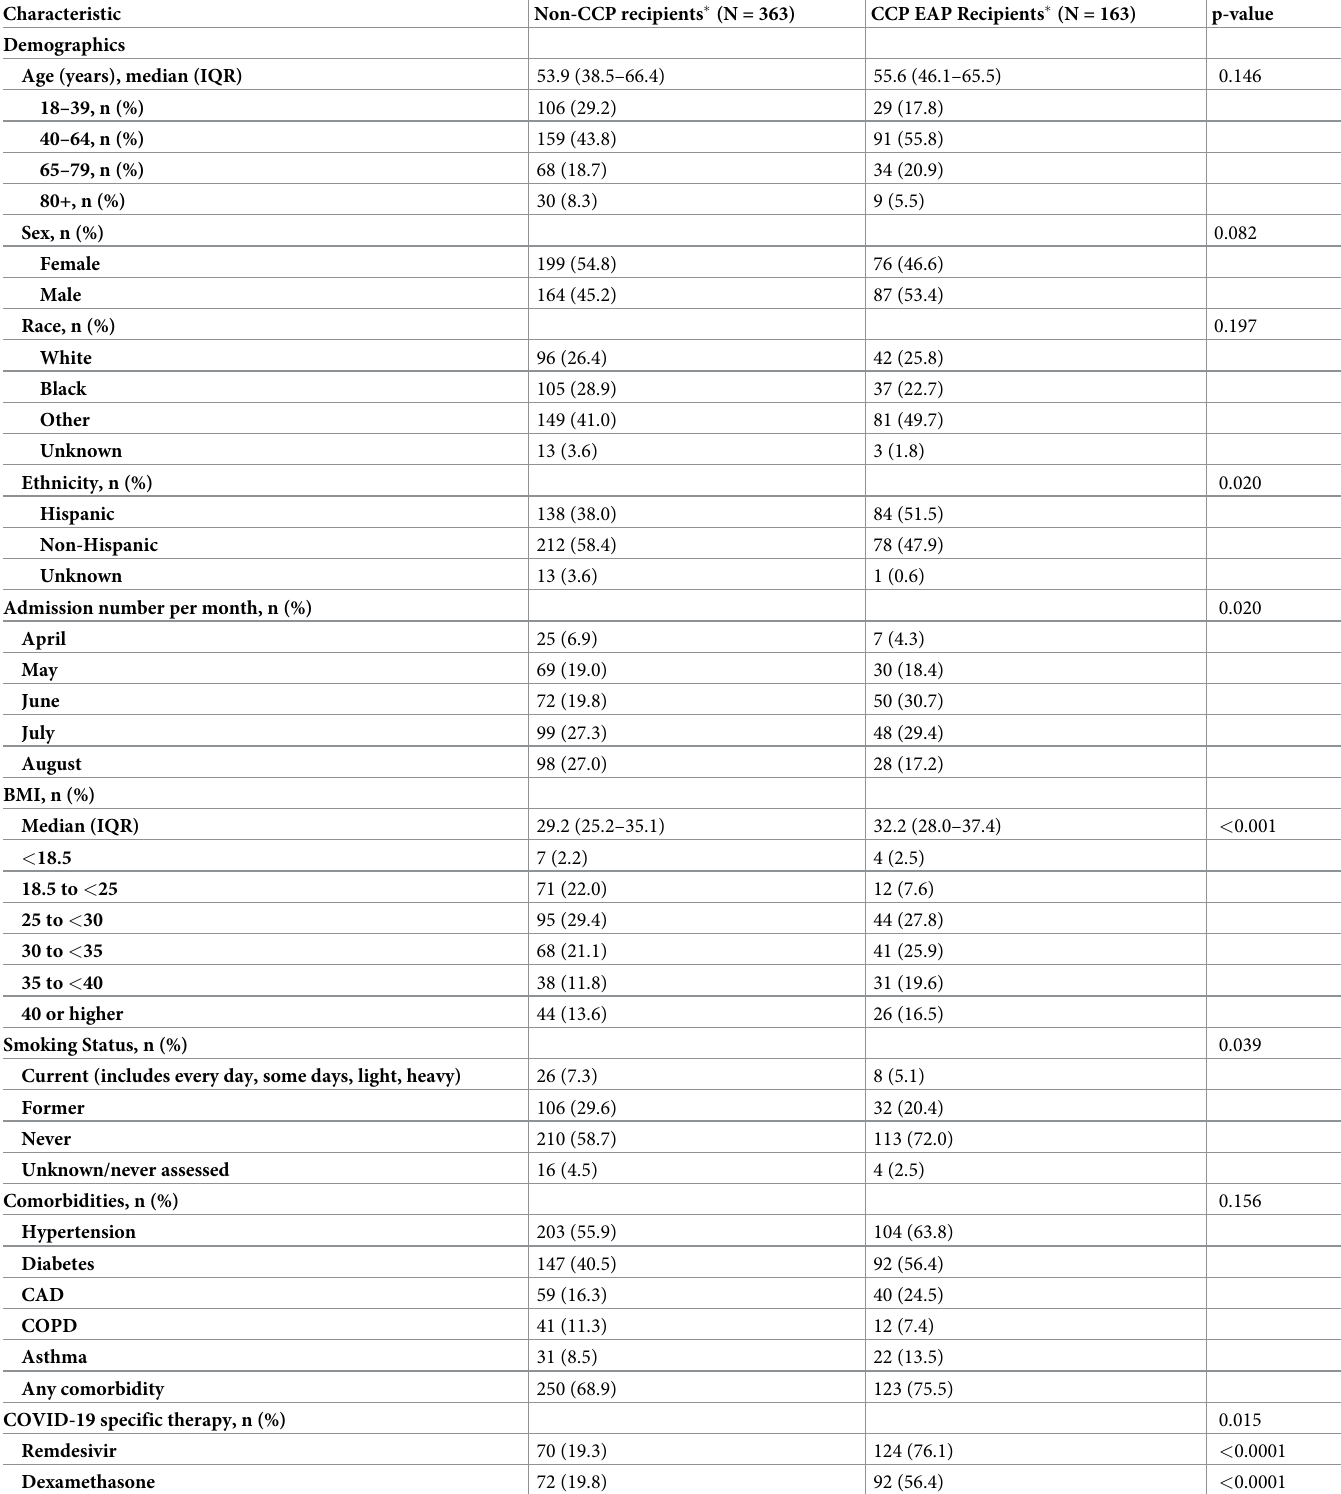
Table 2. CCP recipient and non-recipient